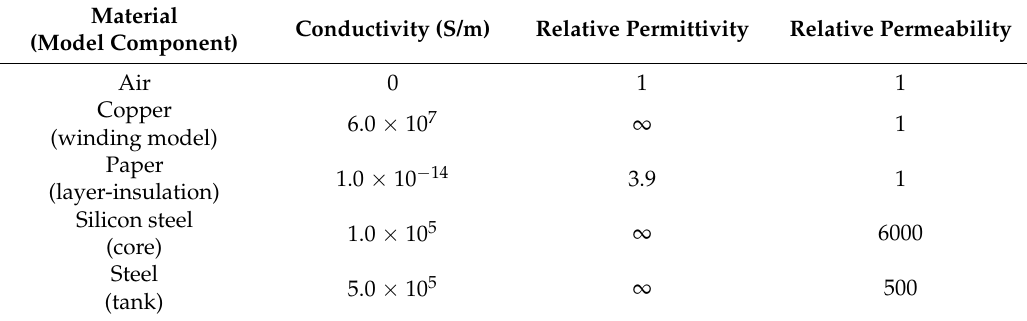
Table 1. Material properties used in the simulation.